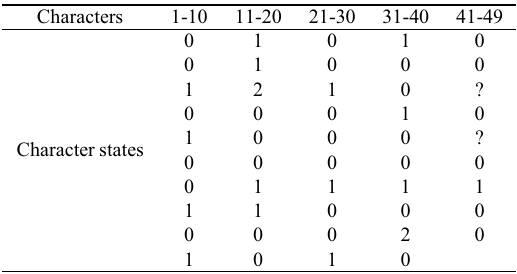
Table 3 . Character states of Otothyropsis marapoama , for 46 characters presented by Schaefer (1998) plus three additional characters included in the reanalysis (47, 48, and 49) (see text for explanation). Characters are listed from top to bottom, arranged in separate groups in